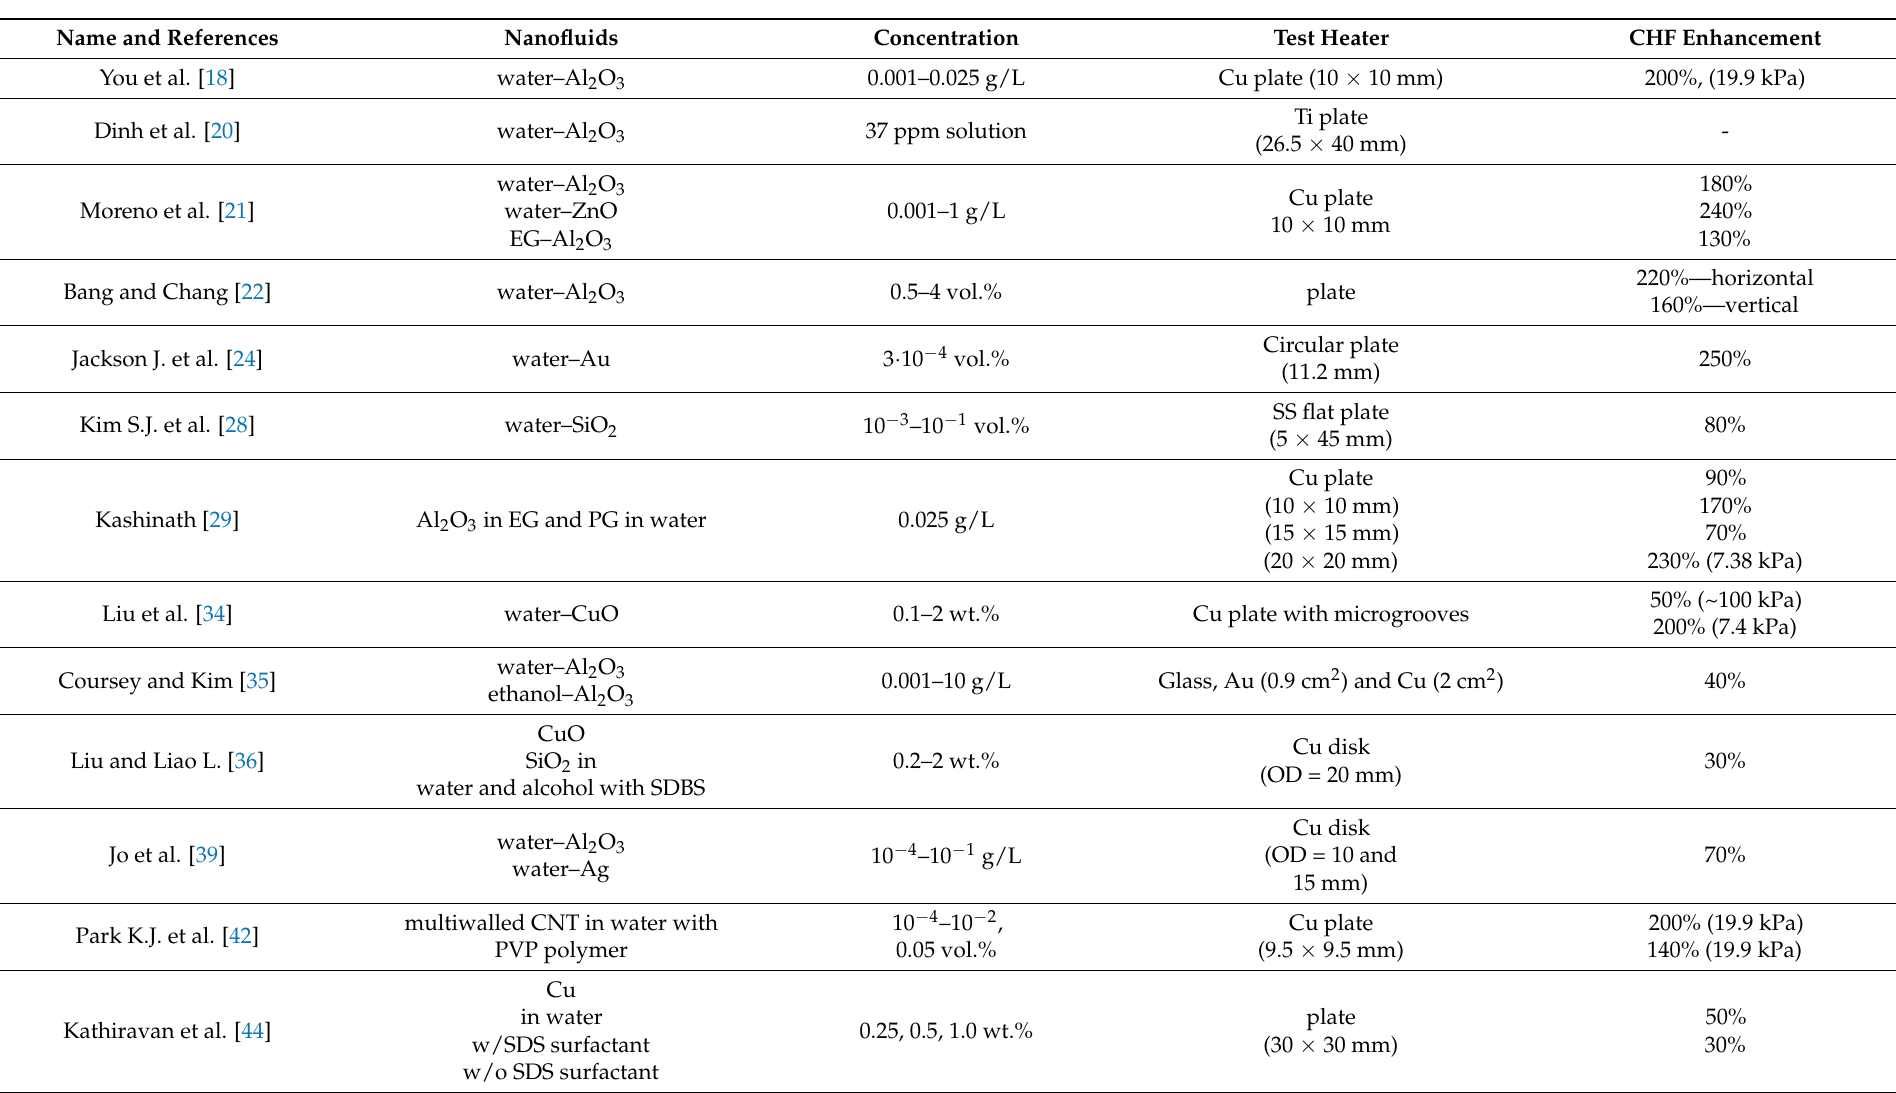
Table 2. Review of experimental studies on CHF of nanofluids in pool boiling on